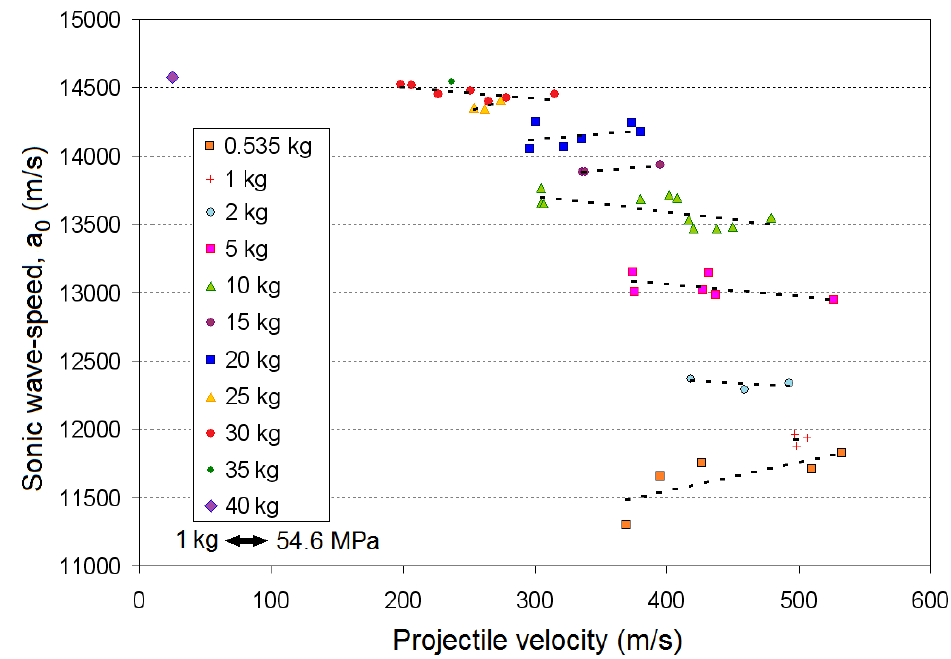
Figure 6. Tension wave velocity versus applied yarn pre-load and impact velocity.